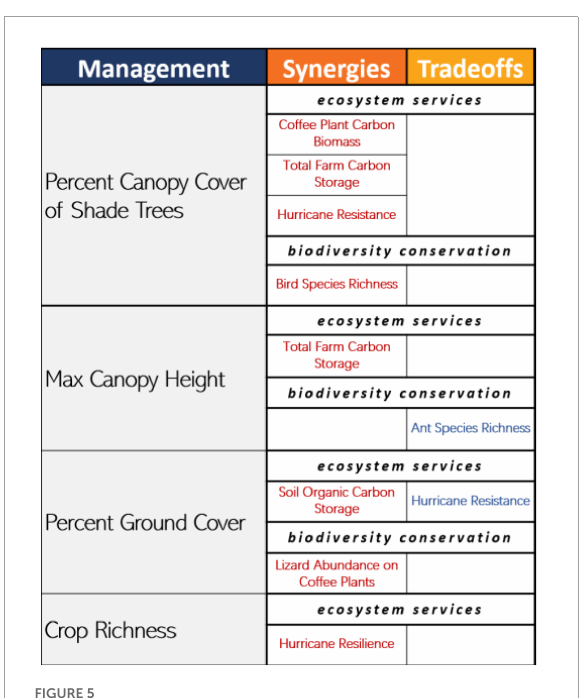
FIGURE5 Summary table of management effects on ecosystem services and biodiversity. Red indicates a positive relationship and blue indicates a negative relationship. This panel contains a scatter plot matrix of the correlations condensed in this